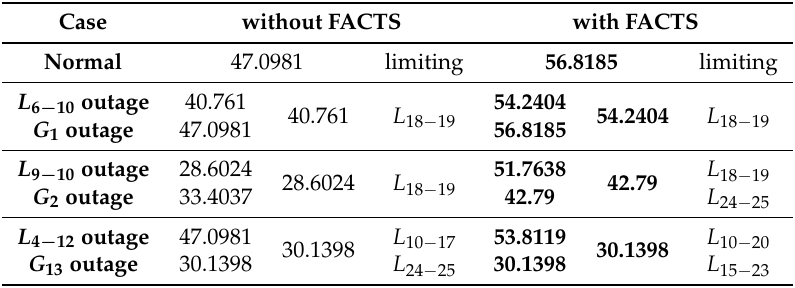
Table 6. TTC values from area1 to area 2 for IEEE 30 bus system.